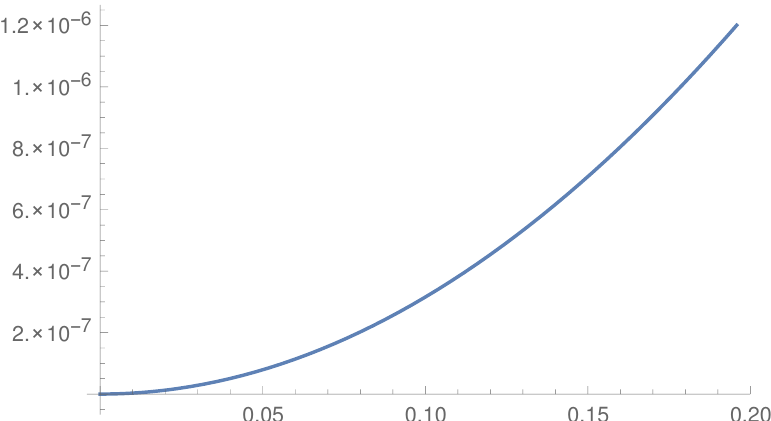
Figure 9. Variations of ¯ F 1 ( θ ) , at T = 100MeV, m e = 0.51MeV, for K - momenta of order e 3 T